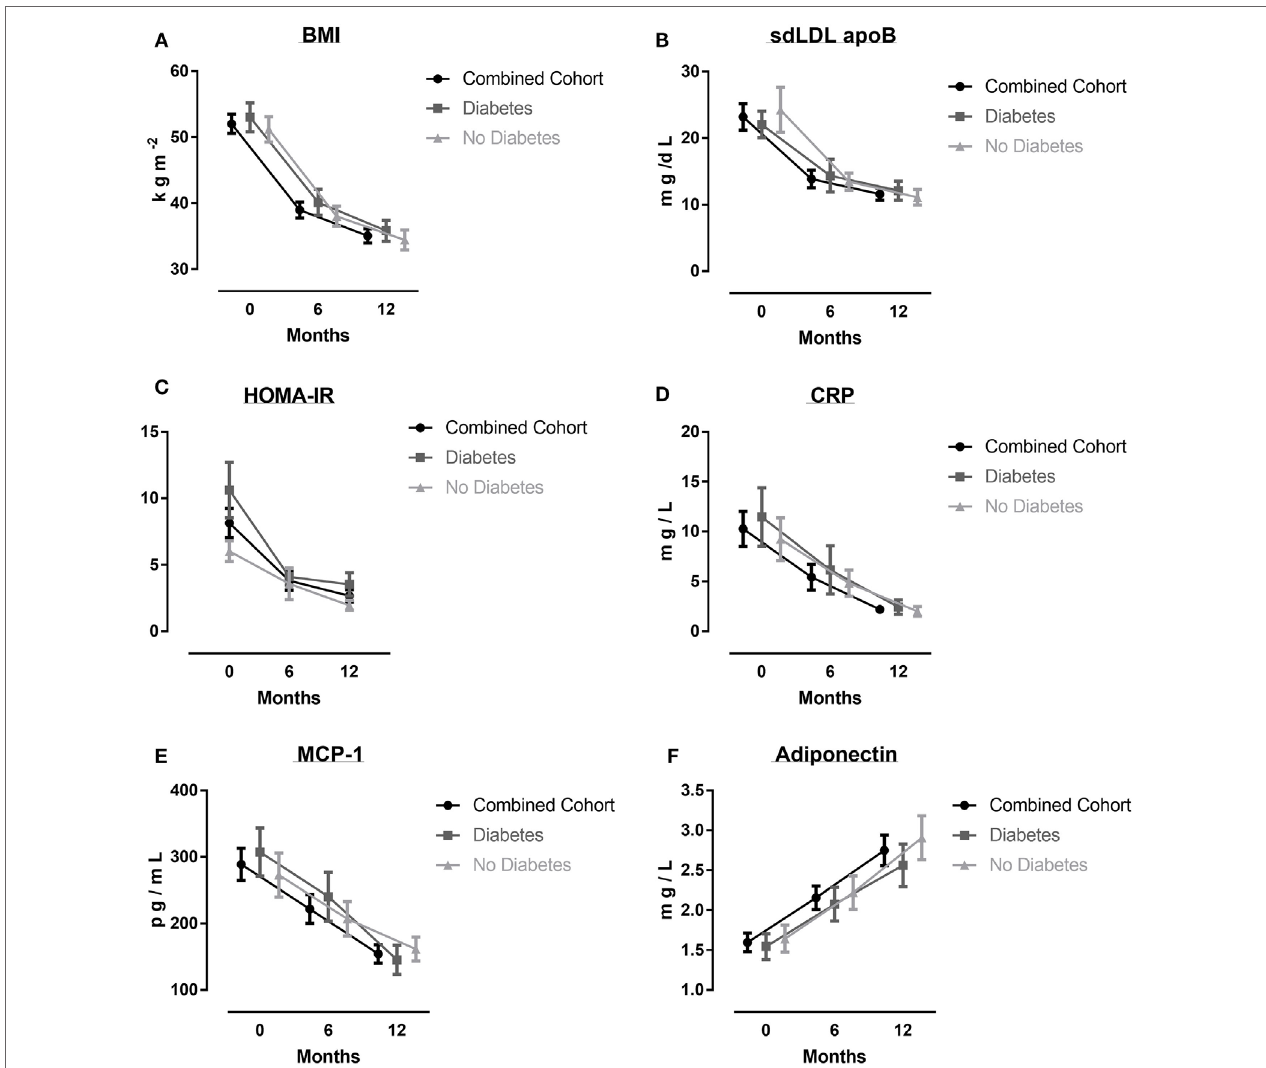
FigUre 1 | Various parameters before, and 6 and 12 months after bariatric surgery: body mass index (BMI) (a) , small-dense LDL apolipoprotein B (sdLDL apoB) (B) , HOMA-IR (c) , CRP (D) , MCP-1 (e) , and adiponectin (F) . Results are given as mean ( ±